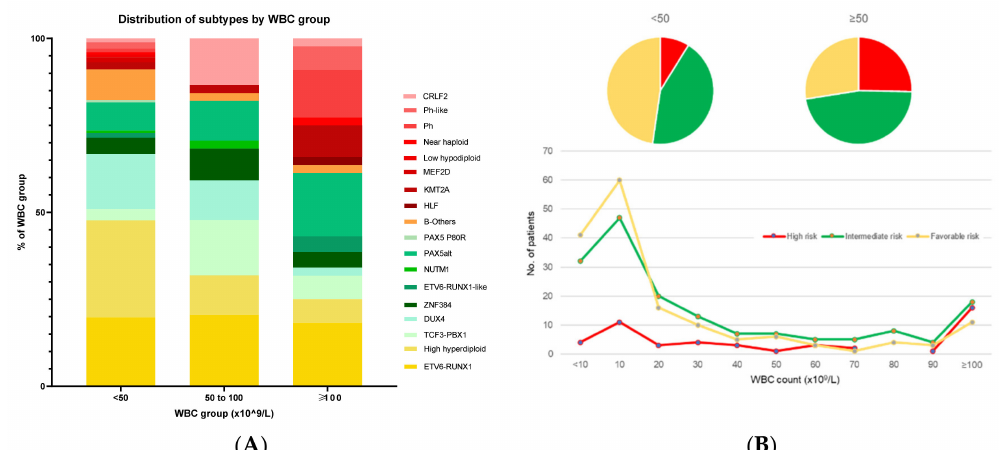
Figure 4. Association of B-cell acute lymphoblastic leukemia (B-ALL) subtypes with presenting WBC count. ( A ) Distribution of subtypes by WBC group, and ( B ) distribution of risk groups across WBC counts. In ( A ), the proportions of individual subtypes within each WBC group are plotted, with subtypes summing to 100% in each category. In ( B ), the numbers of patients in each risk group are plotted by WBC count and the distribution is as shown. Favorable-risk subtypes are in shades of yellow, intermediate-risk subtypes are in shades of green, and high-risk subtypes are in shades of red. B-others is depicted in orange. In general, favorable-risk or intermediate-risk subtypes are associated with low presenting WBC count (<20 × 10 9 /L), whilst higher-risk subtypes tend to present with a higher WBC, particularly Ph-like ALL, which tends to present with WBC >100 k. For the WBC < 50 k group, favorable- and intermediate-risk genetics predominate, accounting for their favorable outcomes. Data are adapted from results of RNA-sequencing of children and adolescents with B-ALL in the Malaysia-Singapore cohort. Abbreviations: WBC, white blood cell